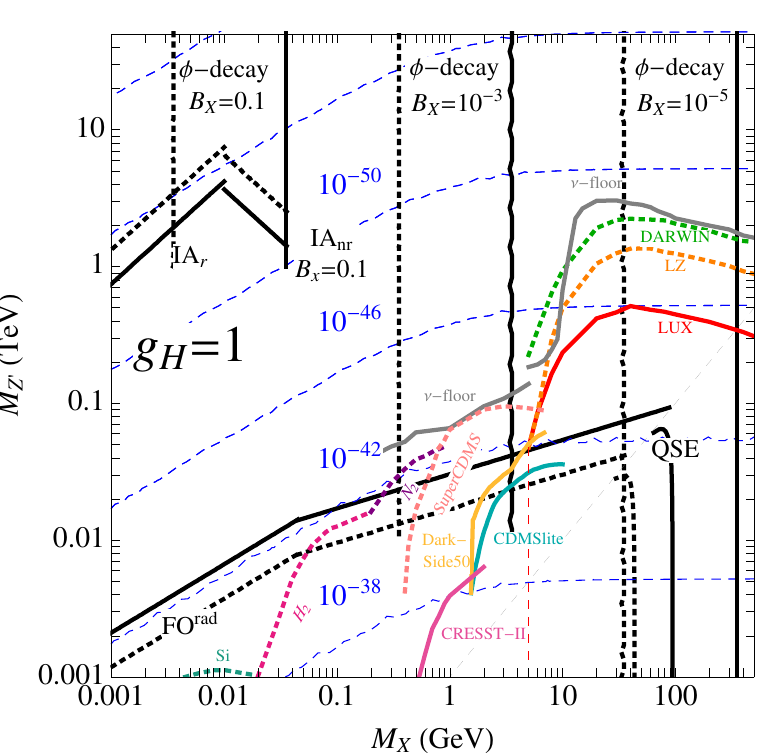
Figure 8. Current exclusions and future sensitivity in the hidden sector dark matter mass M X , Z 0 mediator mass M Z 0 plane, with the hidden sector U(1) gauge coupling g H = 1. The dashed blue contours show (cid:27) SI for Xenon, in units of (cm 2 ). Below the red contour is currently excluded by X N (cid:0) LUX [79]. The future limits from LZ are shown in dotted orange [84], while those from Darwin are shown in green [86]. The current limits from CDMSlite are shown in dark cyan [80, 81]. The new limits from DarkSide50 are shown in orange [82]. The current limits from CRESST-II [83] are shown in pink. The light pink dotted contour shows the projected sensitivity of the Si and Ge HV detectors of SuperCDMS SNOLAB [85]. The dashed contours in the lower left indicate future sensitivity of potential H 2 (pink), N 2 (purple) dissociation experiments [103]. The dark green dotted line in the lower left corner is the future sensitivity of dark matter scattering o(cid:11) electrons in Si semiconductors [92]. Above the grey solid line is below the neutrino (cid:13)oor as reported in [83] and [104]. The black solid (dotted) lines indicate where the dark matter relic density is (cid:10) dm h 2 = 0 : 12 (0 : 012). Labels indicate what mechanism is setting the relic density. The IA nr mechanism is only displayed for B X = 0 : 1. For smaller B X the IA nr validity region extends linearly up to a maximum of M X 0 : 3 GeV. See table 1 for de(cid:12)nitions for each mechanism. (cid:30) is the lightest (cid:24) modulus. The kinetic mixing parameter is set to (cid:15) = 10 (cid:0) 3 . The light dashed line corresponds to M X = M Z 0 . All values of M X shown correspond to some viable dark matter